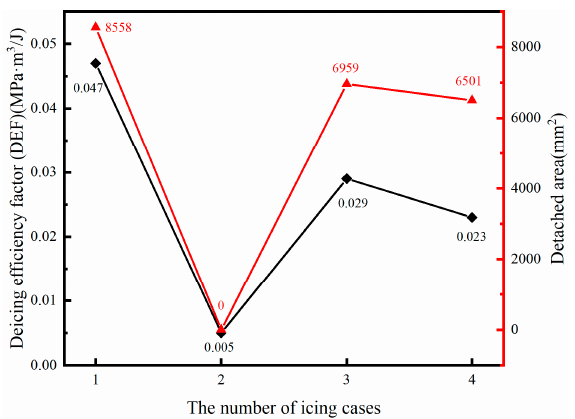
Figure 20. The trend of detached area and deicing efficiency factor (DEF) for four different icing cases.